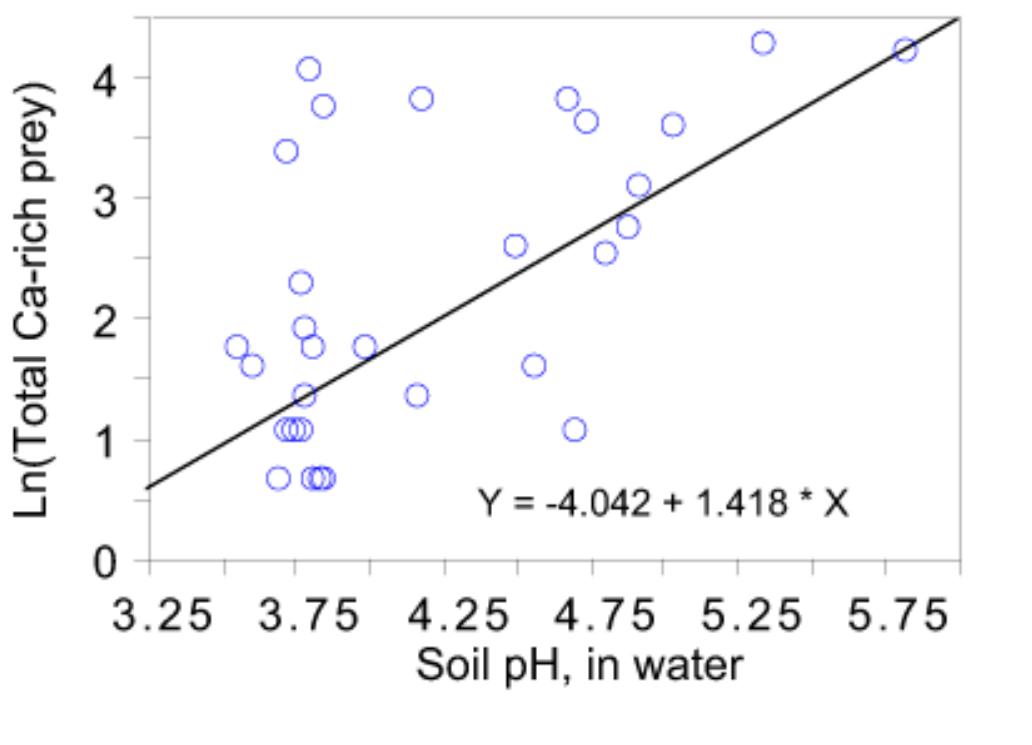
Fig. 4. The relationship between the log-transformed total number of calcium-rich prey and the soil calcium content, in mg/kg, from each site. Ordinary least-squares regression yielded a marginally nonsignificant model: F = 3.734, P = 0.0612, R 2 = 0.094. Line shown represents the predicted best-fit values from the 1,7